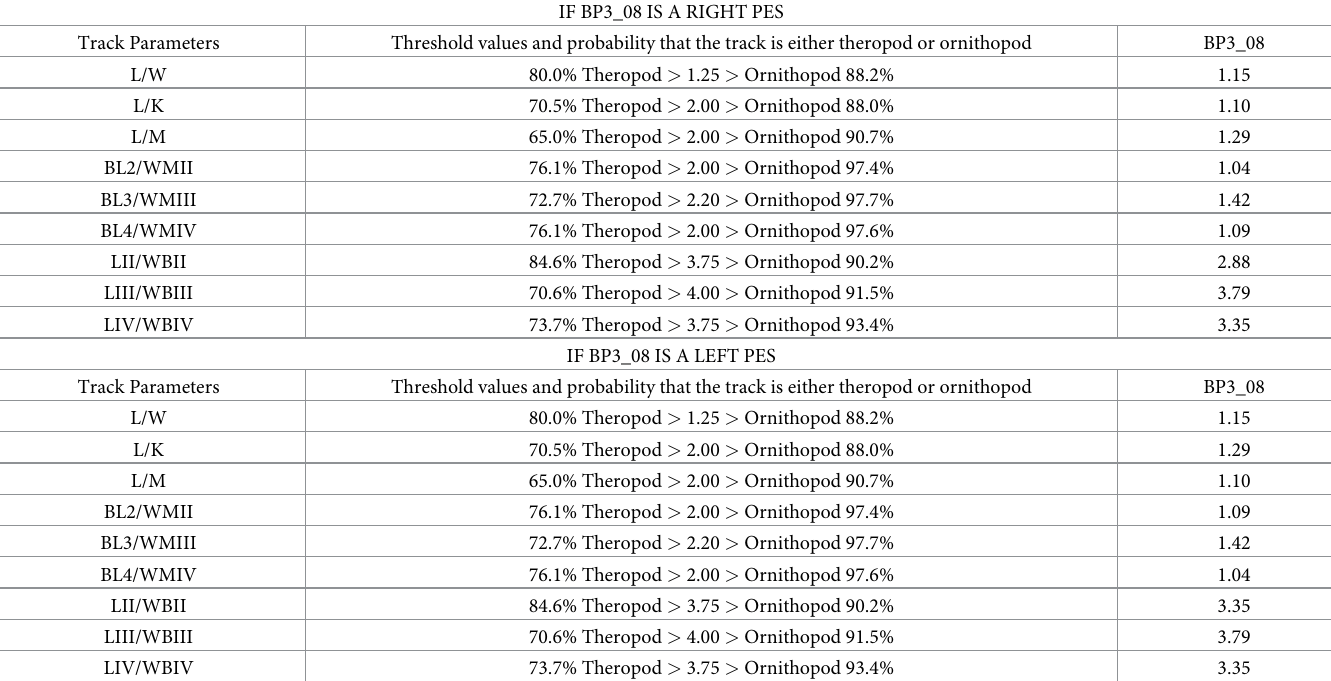
Table 7. Assessment of the trackmaker affinity of